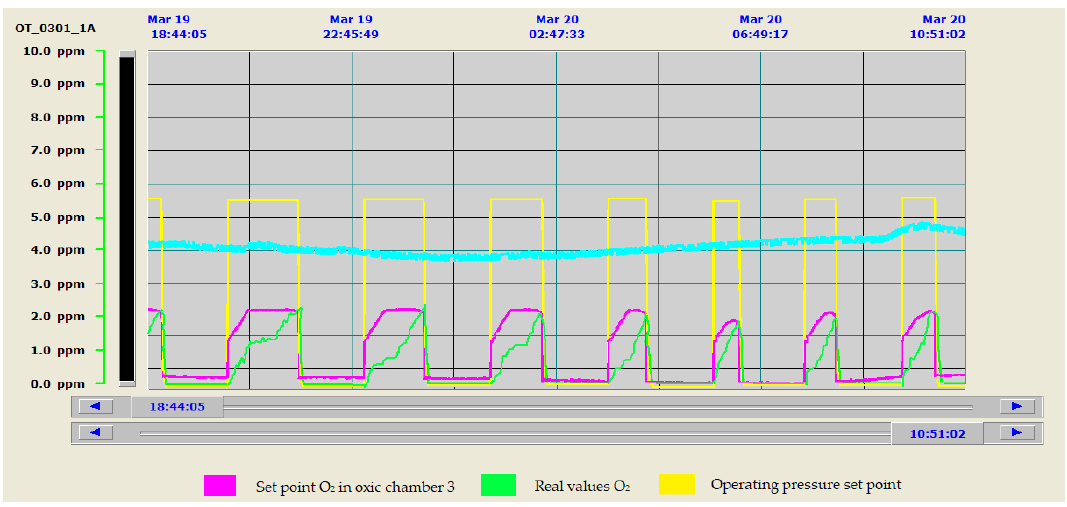
Figure 11. Oxygen evolution in Zone 3 with the old control system. Sensors 2020 , 20 ,